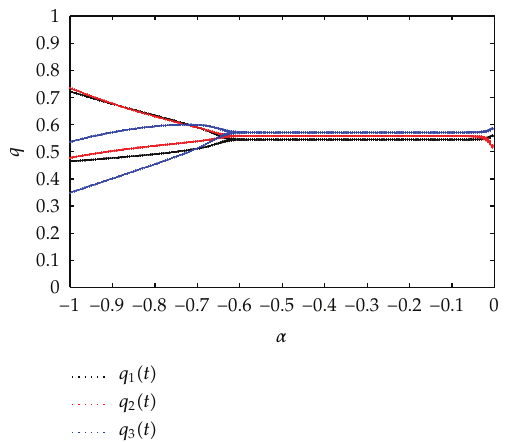
Figure 4: Bifurcation with α ∈ (cid:5) − 1 , 0 (cid:6) , β (cid:7) 0 . 25.